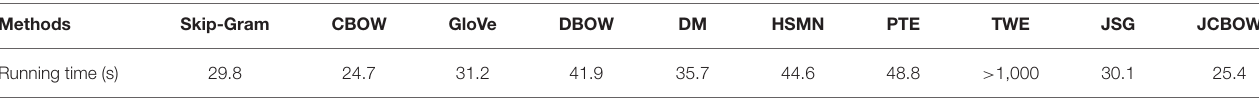
TABLE 5 | Running time evaluation on 20News dataset.